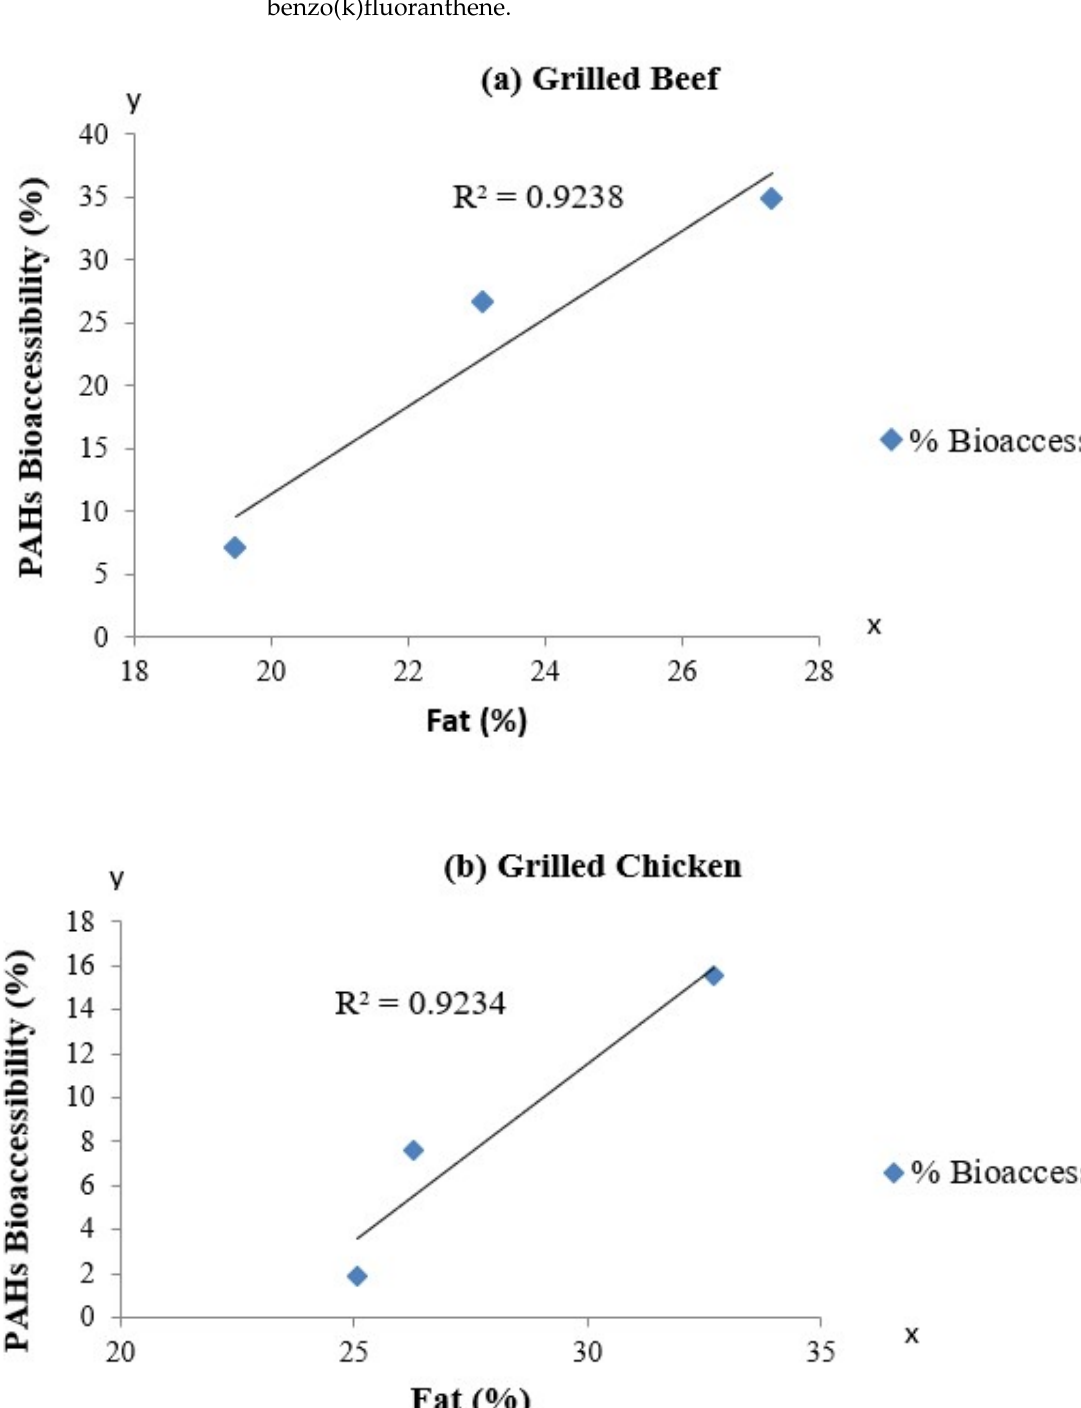
Figure 7. Relationship between the bioaccessibility of PAHs and the fat content in ( a ) grilled beef and ( b ) grilled chicken samples.